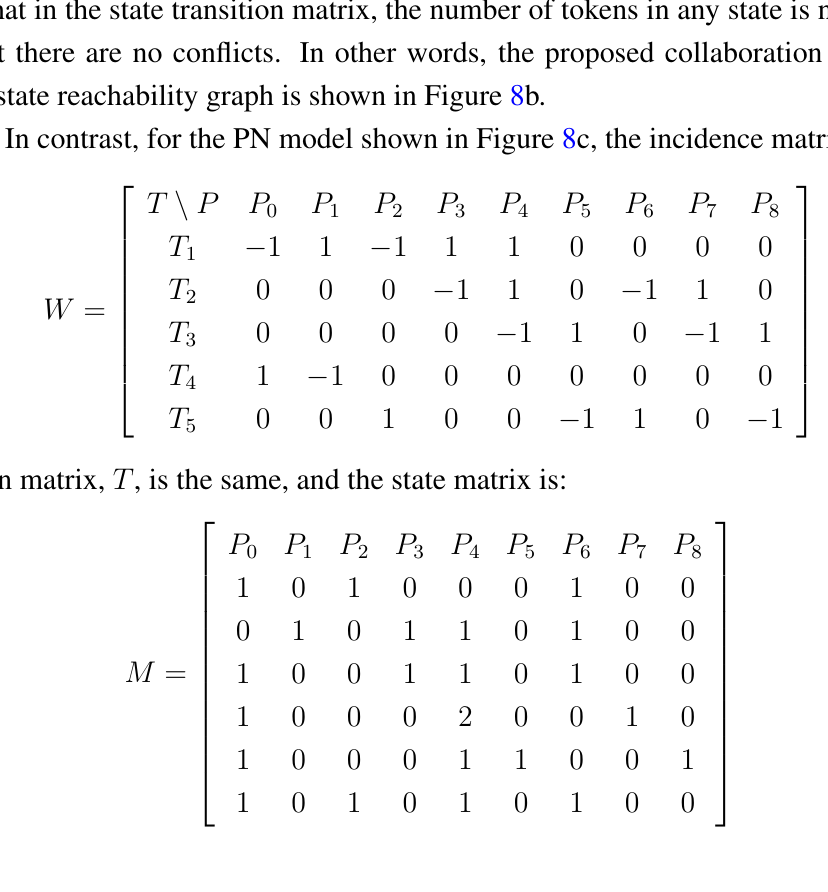
Figure 9. Java Agent Development Environment (JADE) multi-agent